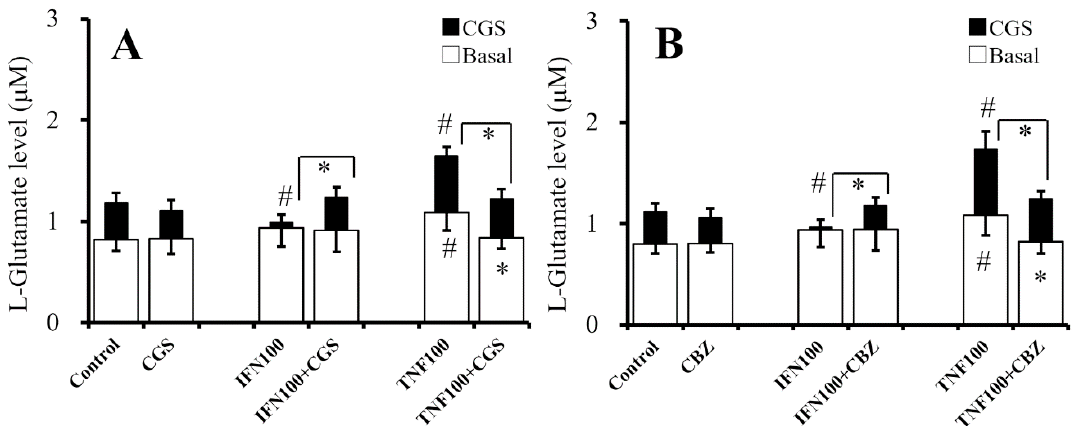
Figure 8. Interaction between chronic administration of cytokines, sub-effective concentration of CGS21680 (10 nM), and therapeutic-relevant concentration of CBZ (20 μ M) on 100 nM CGS21680-evoked L-glutamate release. Effects of chronic administration of IFN γ (100 IU/mL), TNF α (100 IU/mL), and CGS (10 nM) on basal (opened) and 100 nM CGS-evoked (closed) releases of L-glutamate from cultured astrocytes are indicated in Figure 8A. Effects of chronic administration of IFN γ (100 IU/mL), TNF α (100 IU/mL), and CBZ (20 μ M) on basal (opened) and 100 nM CGS-evoked (closed) releases of L-glutamate from cultured astrocytes are indicated in Figure 8B. Ordinates indicate mean levels of L-glutamate ( μ M) ( N = 6). * p < 0.05 relative to non-CGS ( A ) or non-CBZ ( B ) and # p < 0.05 relative to control by two-way ANOVA with Tukey’s post hoc test.